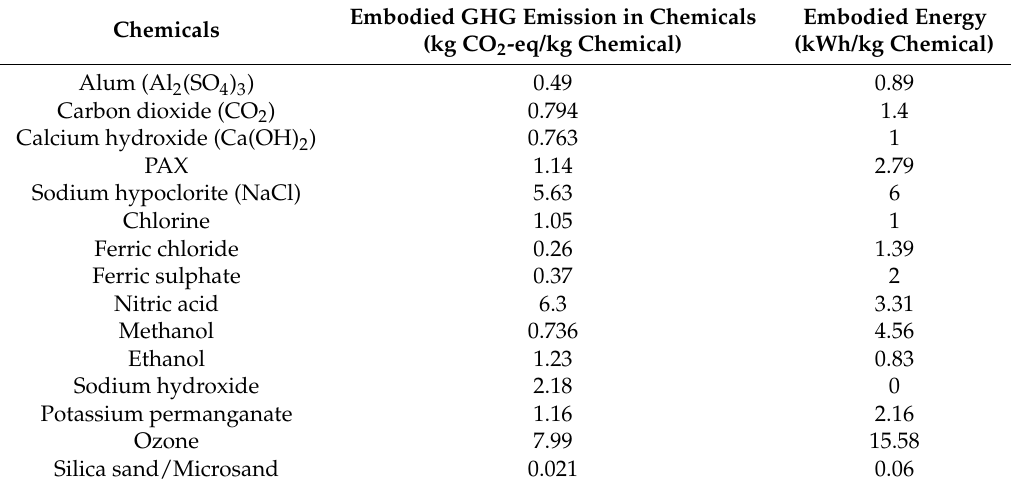
Table 10. Default coefficients, employed in WM2, for the computation of energy and emissions associated with chemical